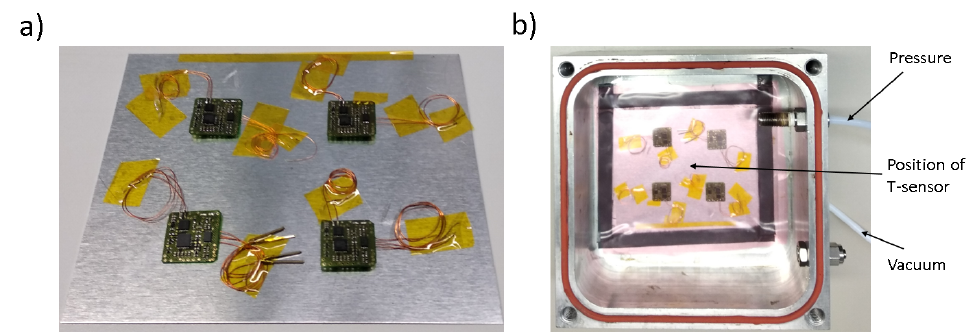
Figure 6. Experimental setup for sensor node temperature tests. ( a ) sensor nodes on aluminum plate; ( b ) sensor nodes inside a miniature autoclave with vacuum bagging, vacuum and pressure.